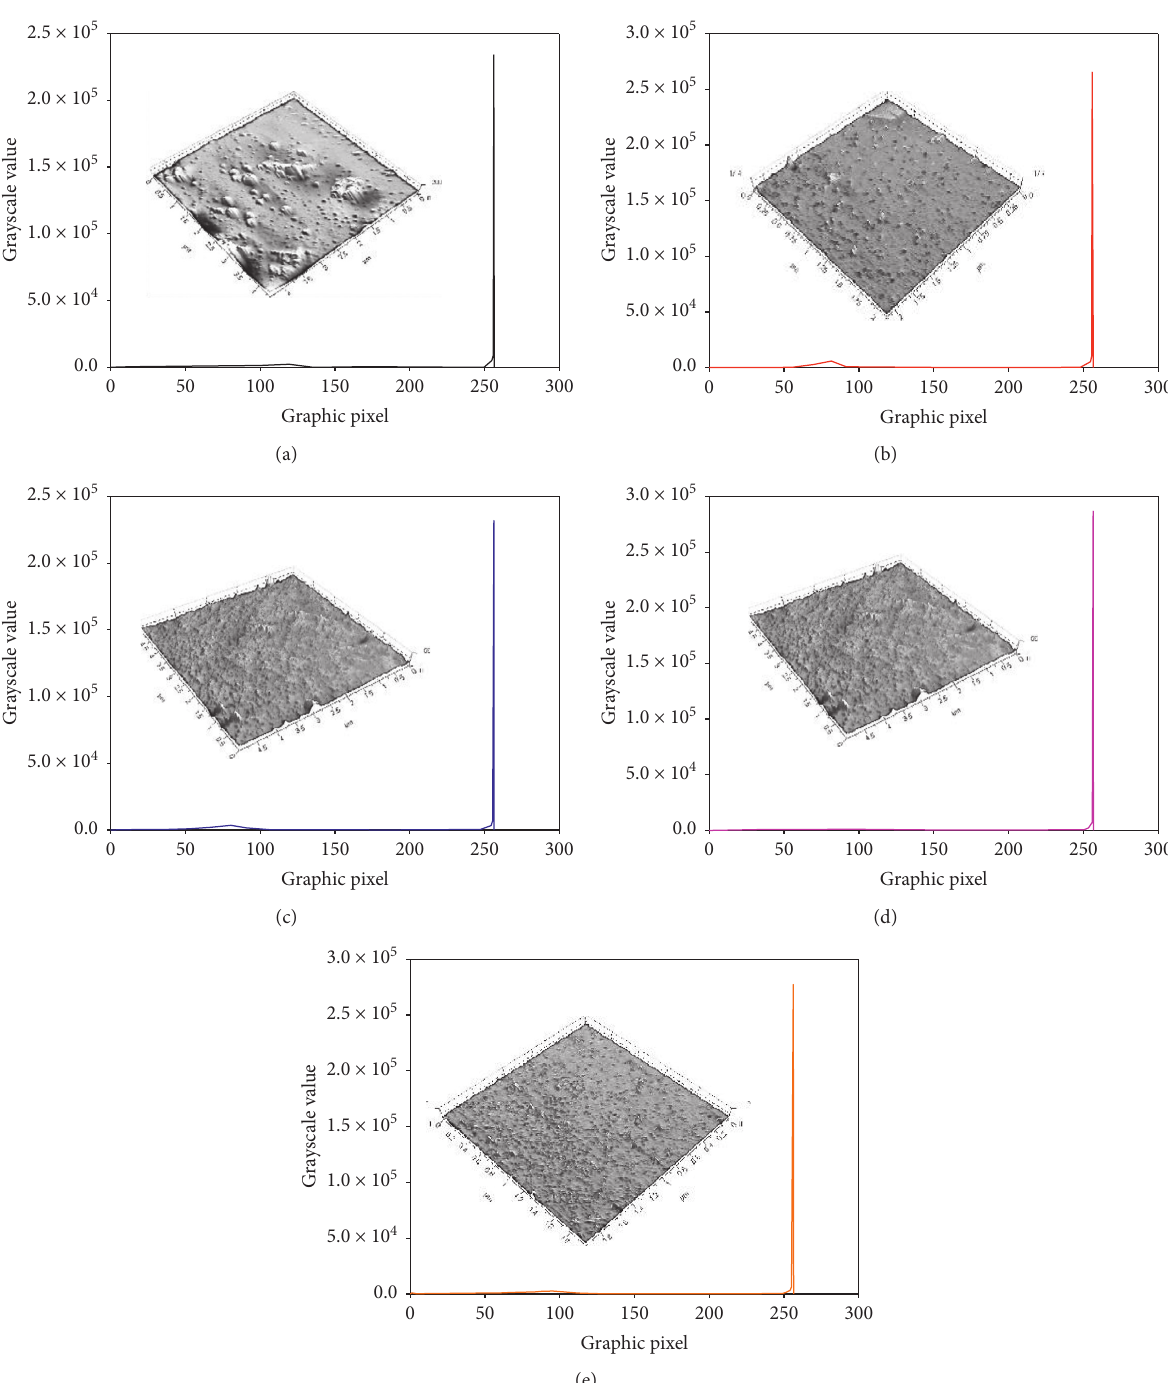
Figure 12: Grayscale analysis on AFM results of GTC (0% to 40%). (a) GTC-0; (b) GTC-10; (c) GTC-20; (d) GTC-30; (e)